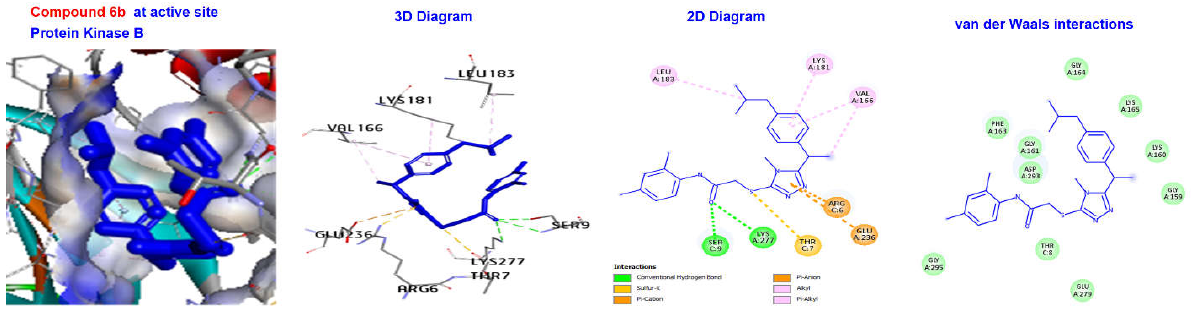
Figure 5. Binding pocket of docked ligand 6b in active site of Protein Kinase B.